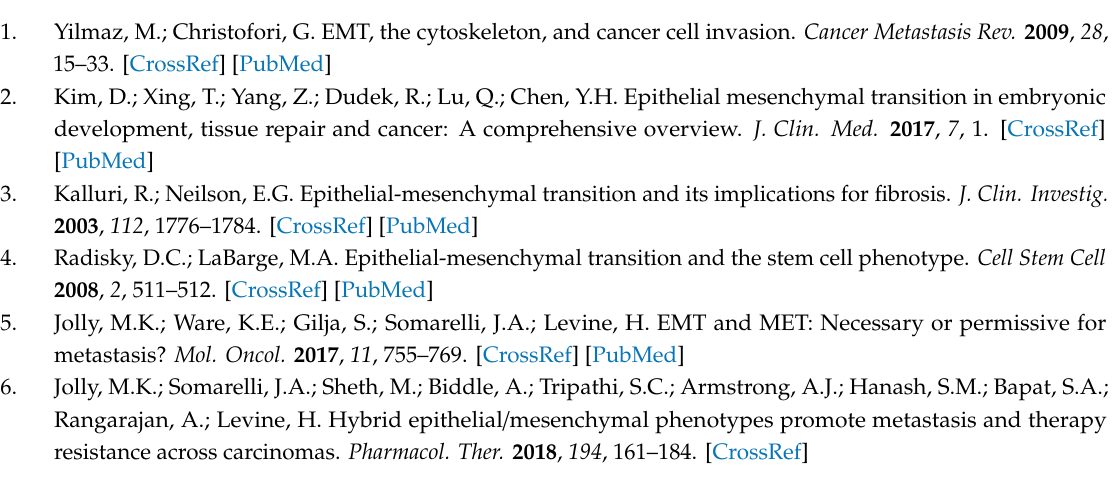
Table S1: Primer sequences used for real-time PCR study. Figure S1: Wound healing assay results revealing migration of the EGF treated cells. Supplementary video S1 shows the flow of cells in the entire channel from the inlet to the outlet reservoir. Supplementary video S2 shows the motion of cells through the gaps between the blockages in the channel. Supplementary video S3 shows the motion of cells through the constricted passages in the